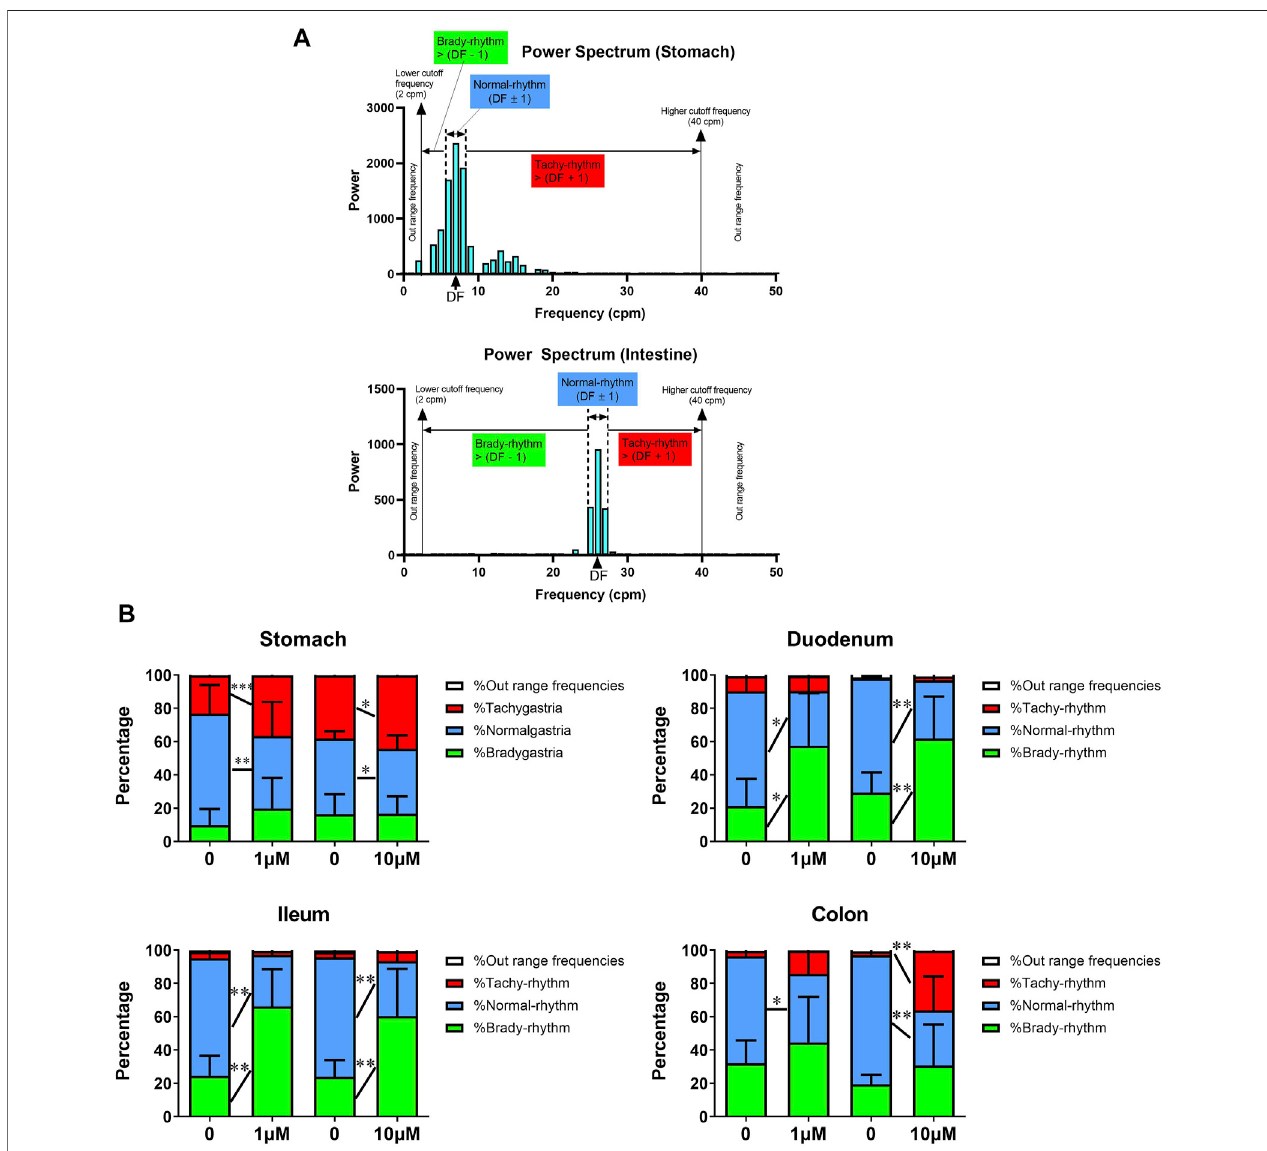
FIGURE 1 | Acute In vitro effects of cisplatin on pacemaking potentials in the gastrointestinal tract of Suncus murinus . (A) A representative power spectrum of the (upper) stomach or (lower) intestinal segment in S. murinus . The power distribution was de fi ned as brady-rhythm range frequencies [2 cpm to (dominant frequency (DF)) − 1)];normal-rhythmrangefrequencies[(DF − 1)to(DF+1)];tachy-rhythmrangefrequencies[(DF+1)to40cpm];andout-of-rangefrequencies[( < 2cpm)and( > 40 cpm)]. (B) Graphs showing the effect of cisplatin (1 – 10 μ M) on the percentage of each range in the power spectrum in the stomach (1 μ M: n (cid:1) 13; 10 μ M: n (cid:1) 14), duodenum (1 μ M: n (cid:1) 6; 10 μ M: n (cid:1) 8), ileum (1 μ M: n (cid:1) 6; 10 μ M: n (cid:1) 9) and colon (1 μ M: n (cid:1) 7; 10 μ M: n (cid:1) 6). Data are mean values ± standard deviations. Signi fi cant differences relative to the baseline are indicated as * p < 0.05, ** p < 0.01 or *** p < 0.001 (paired t -tests).